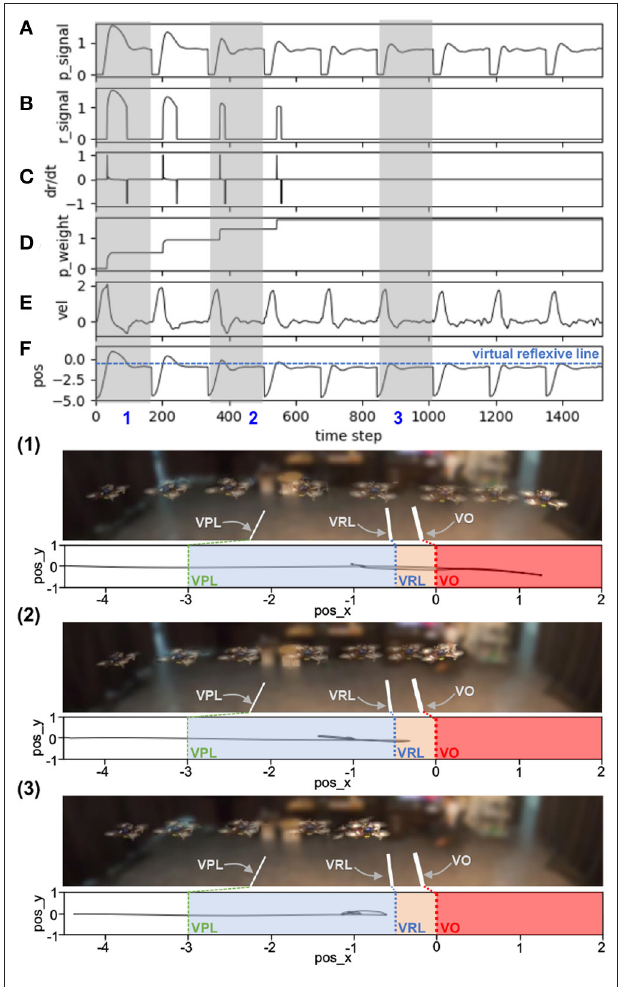
FIGURE B2 | Real-time data of speed adaptation during online learning while flying the UAV at a maximum speed of 1.5 m/s. (A) Predictive signal. (B) Reflexive signal. (C) Derivative of the reflexive signal. (D) Predictive weight. (E) Actual speed (x-axis) of the UAV. (F) Position on the x-axis of the UAV compared to the virtual reflexive line (blue line). The gray areas represent three periods and show the UAV’s position with respect to the virtual predictive line (VPL), virtual reflexive line (VRL), and virtual obstacle (VO). These three periods are shown in the three snapshots together with the corresponding estimated trajectories (1, 2, 3) namely the beginning of learning (1), during learning (2), and after learning (3).